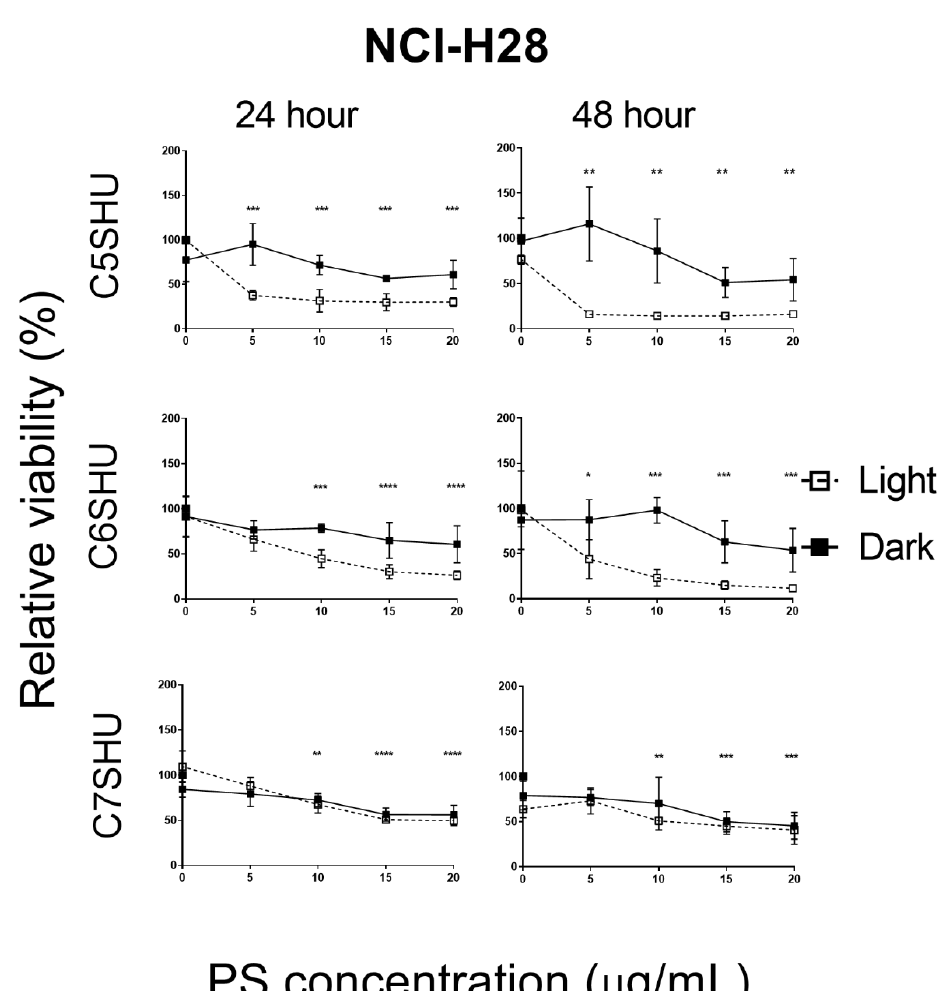
Figure 5. PS-induced cytotoxicity on NCI-H28 cells as determined by the WST-8 assay 24 and 48 h after PDT. Cells received C5SHU, C6SHU, and C7SHU treatments in dark and light conditions. Results are expressed as the mean ± SD of three independent experiments performed in triplicate. The varying significance of light treatments relative to the untreated control are indicated by * ( p ≤ 0.05), ** ( p ≤ 0.01), *** ( p ≤ 0.001), and **** ( p ≤ 0.0001).